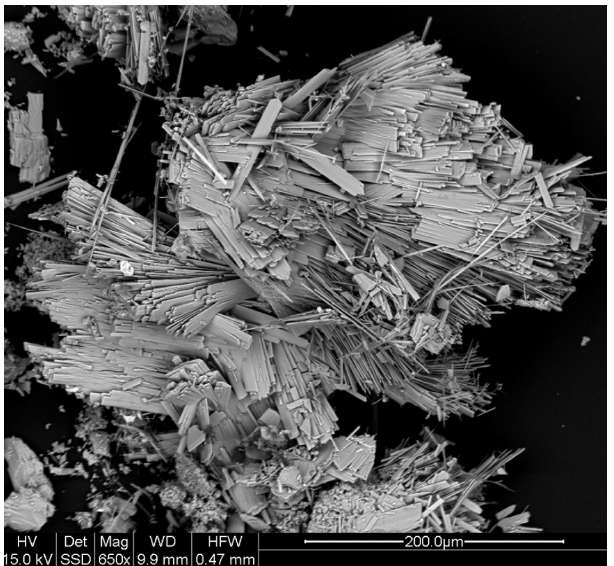
Figure 3. Back-scattered electron image of manganrockbridgeite laths.